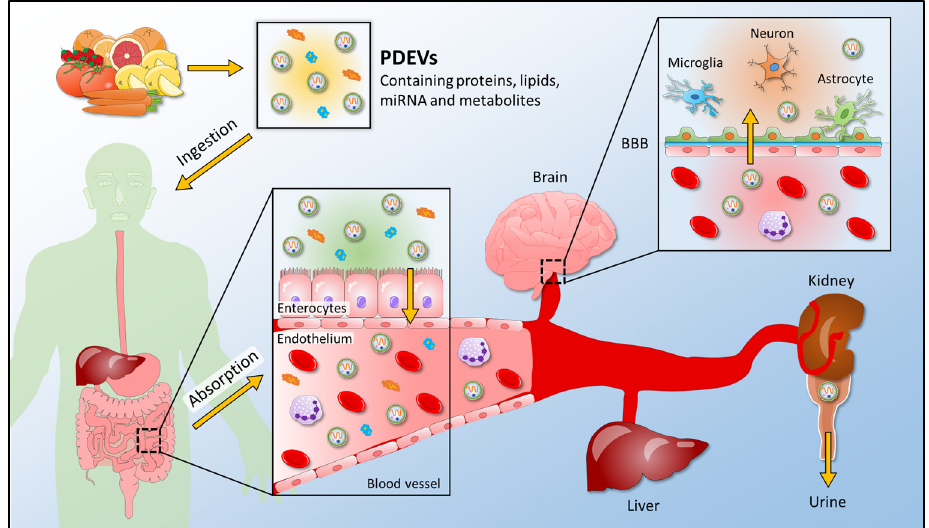
Figure 4. A schematic view for the uptake of plant-derived extracellular vesicles into the human body. PDEVs containing proteins, lipids, miRNA, and metabolites enter the human body after edible plant ingestion. In the gastrointestinal tract, where food is digested, PDEVs are absorbed and enter the bloodstream; thus, reaching the final recipient organs, such as the brain, liver, and kidney. PDEVs release their content in target organs and exert their biological properties. They can cross the BBB and reach the cells of the central nervous system, or they can be found in the urine of plant-eating humans. PDEVs, plant-derived extracellular vesicles; BBB, blood-brain barrier.